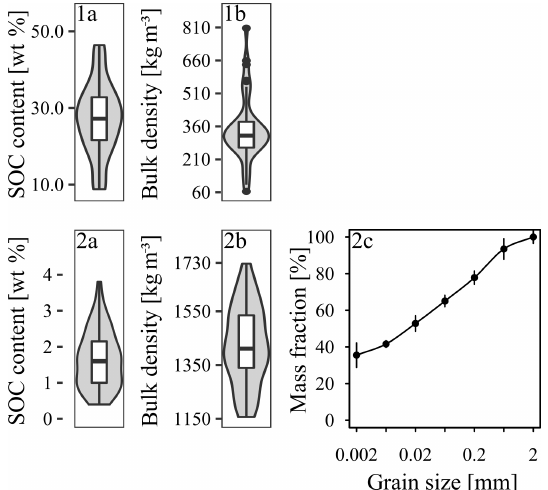
Figure 4. Predictor variables for (1a, 1b) Quinuas (46 samples) and (2a–c) Laipuna (51 samples), showing the (1a, 2a) SOC content, (1b, 2b) bulk density, and (2c) particle size distribution displayed as a cumulative distribution function (mean values with standard deviation). High organic matter contents prevented measurements of the particle size distribution in